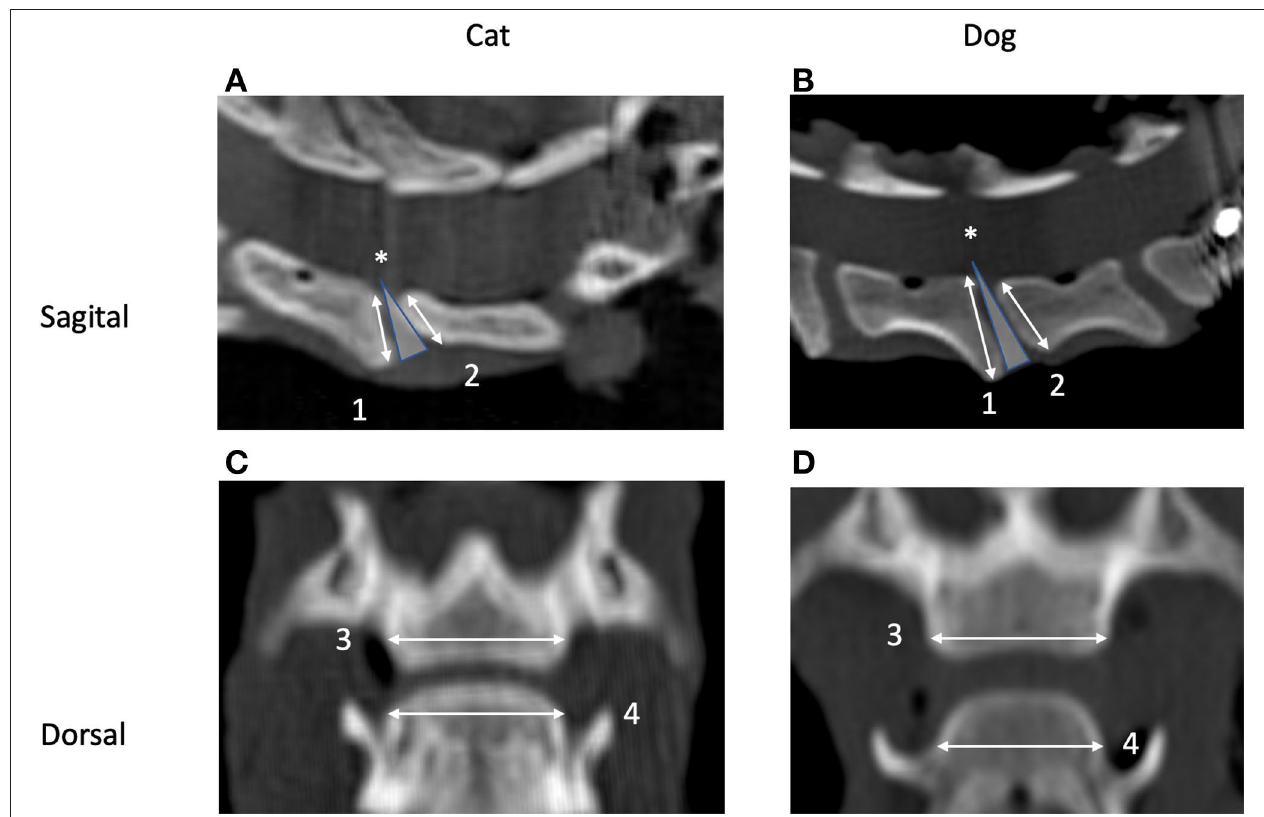
FIGURE 2 | Sagittal (A,B) and dorsal (C,D) CT images of the segment C5–C6 in a cat (A,C) and a dog (B,D) . Cranial is to the left (A,B) and to the top (C,D) . Images originate from the midsagittal (C,D) and middorsal planes (A,B) . Measurement of height (1 and 2) and width (3 and 4) of the caudal (1 and 3) and cranial (2 and 4) vertebral endplates and definition of the intervertebral disc (IVD) wedge angle (*) are shown as